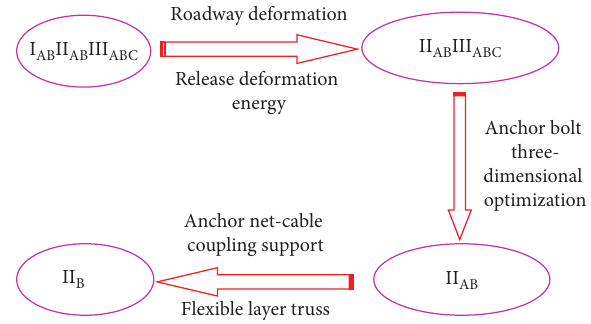
Figure 10: Composite deformation mechanisms of the transfor- mation